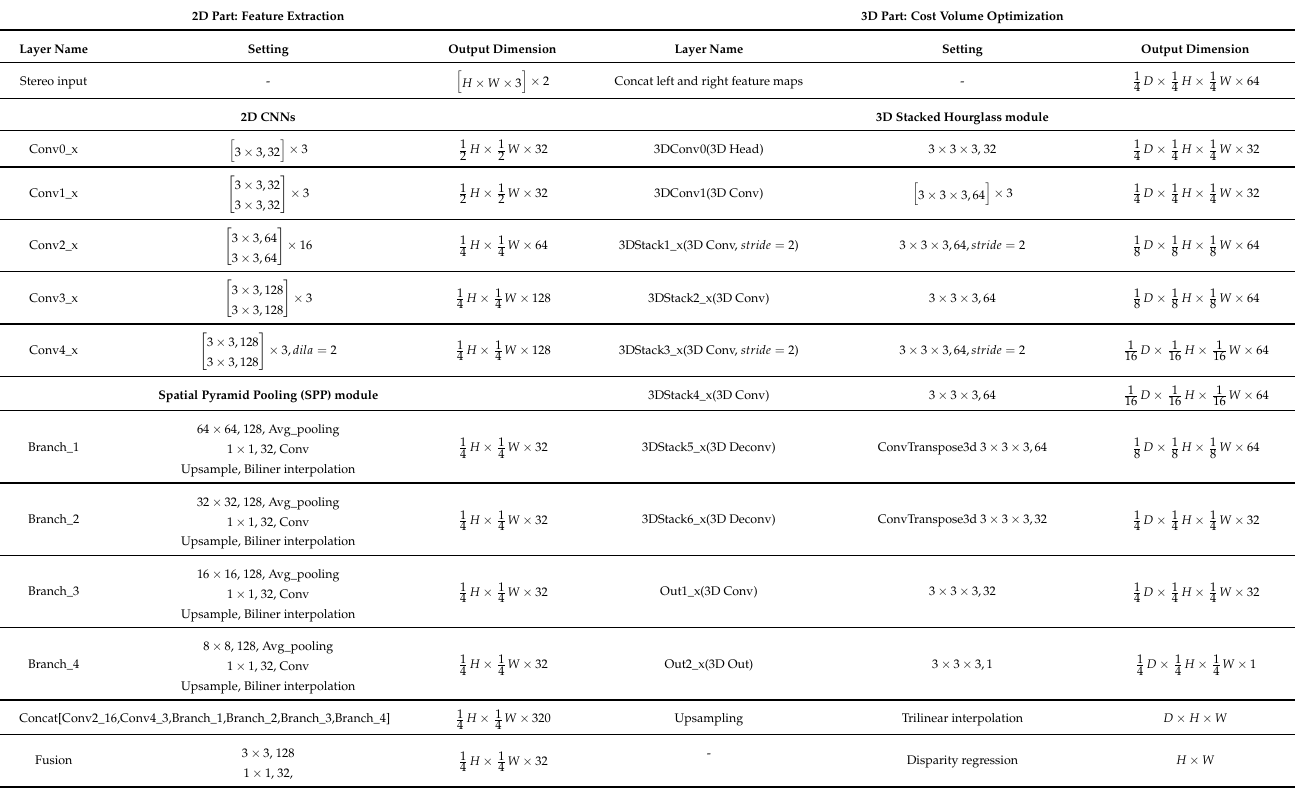
Table 2. Parameters of PSMNet architecture. Batch normalization and ReLU layers are used except the summation operations. H and W denote the height and width of an input pair. D means the disparities of the stereo input